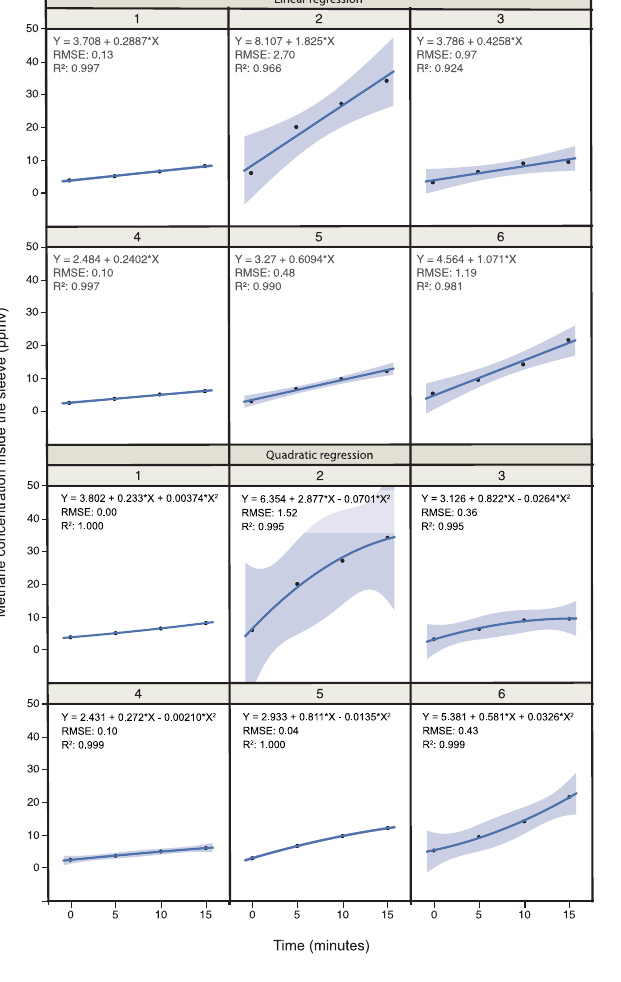
Figure 5. Contrasting methane concentration changes in the semi- rigid sleeve from enclosed gas samples measured in a manual mode (syringe) from tree stems. In the first six runs (top quad- rants) the concentration changes were regressed with a linear fit, while in the second set of runs they were regressed with a quadratic fit (non-linear). All runs 1–6 were measured on Heisteria concinna stems from a tropical lowland forest. The blue line corre- sponds to 95% confidence intervals, RMSE = root mean square er- ror, R 2 = coefficient of determination, Y = methane concentration